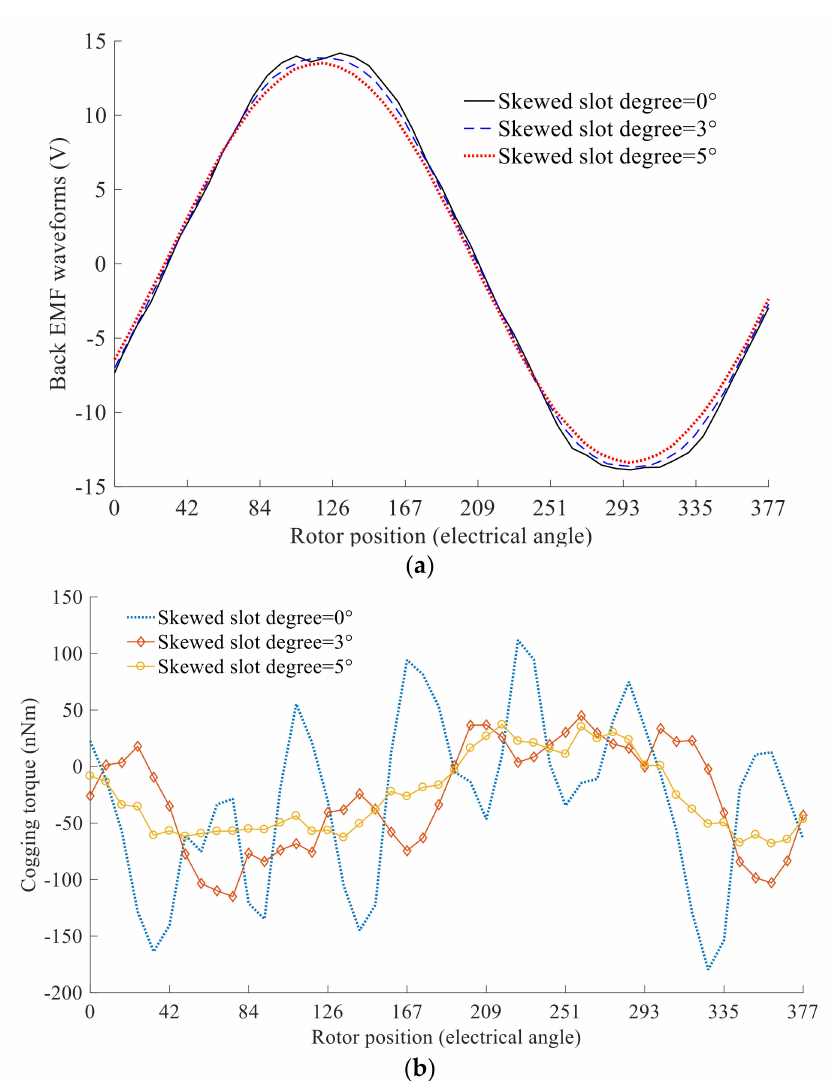
Figure 5. The comparison of back EMF waveform and cogging torque of the VFMPM machine in weakened flux condition. ( a ) Back EMF waveform; ( b ) Cogging